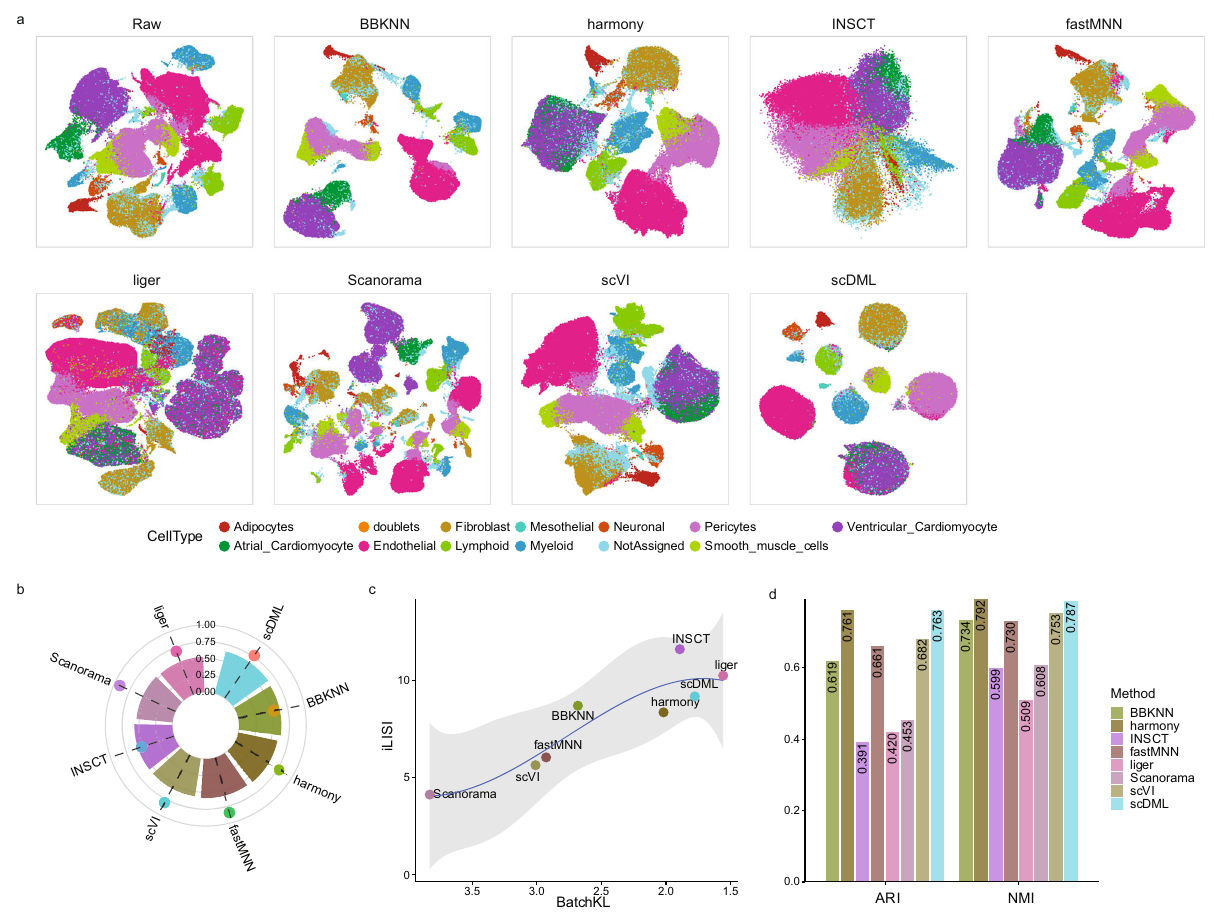
Fig. 6 | scDML enables integrating large numbers of batches and simulta- neously removing batch effect for the healthy human heart dataset with 140 batches. a UMAP embedding computed from different methods, in which the points are colored by cell type. b Bar plot shows the value of ASW_celltype and ASW_batch,inwhichthebarheightdenotesthevalueofASW_celltypeandthepoint heightdenotesthevalueofASW_batch.HigherASW_celltypeandlowerASW_batch